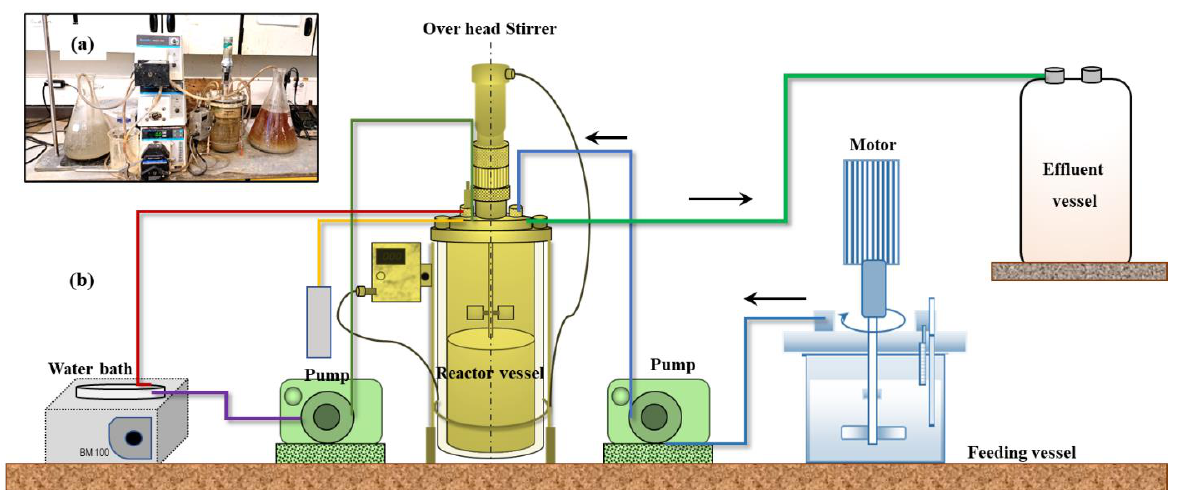
Figure 1. ( a ) A digital photograph of bioreactor/related support equipment and tubing. ( b ) a schematic diagram of bioreactor setup. The red line is the heated water, the green line is the effluent, the yellow line is the air input, and the blue line is the feed solution.